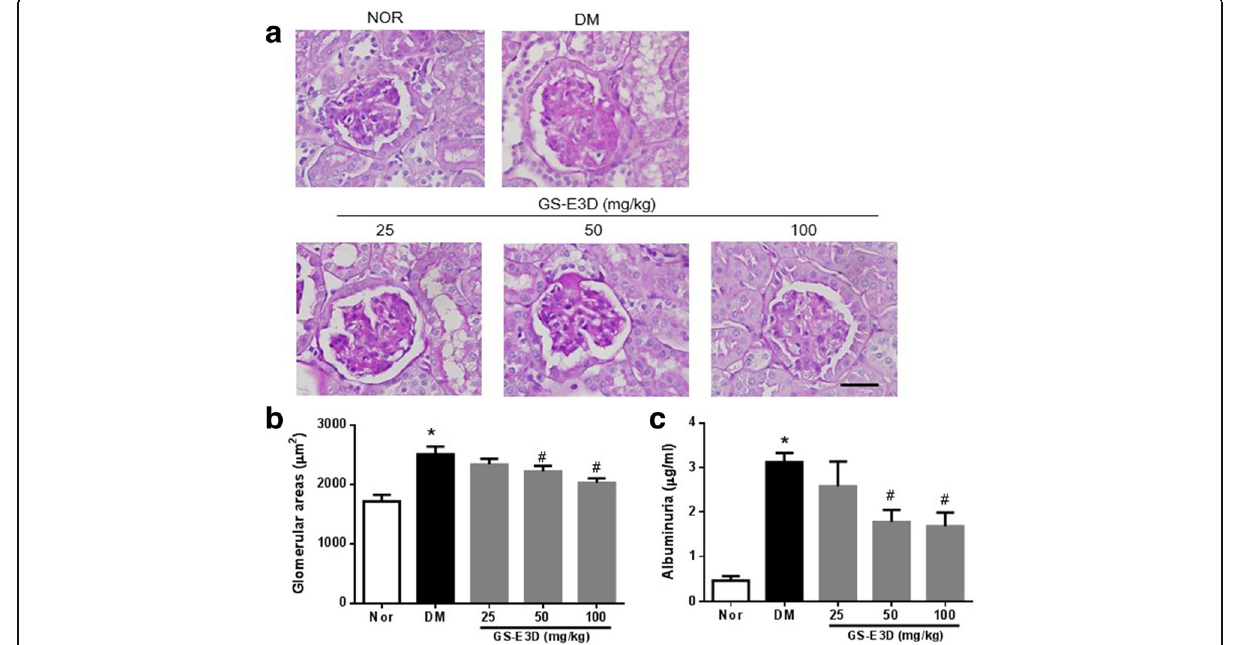
Fig. 1 Renal histopathology and albuminuria. ( a ) Periodic acid-Schiff staining of glomeruli. Scale bar equals 50 μ m. ( b ) Glomerular volume and ( c ) albuminuria in the indicated study groups. NOR, normal rat; DM, streptozotocin-induced diabetic rat; GS-E3D, DM treated with the indicated dose of GS-E3D. All data were expressed as mean ± the standard error of the mean ( n = 8); * p < 0.05 vs. NOR group; # p < 0.05 vs. DM